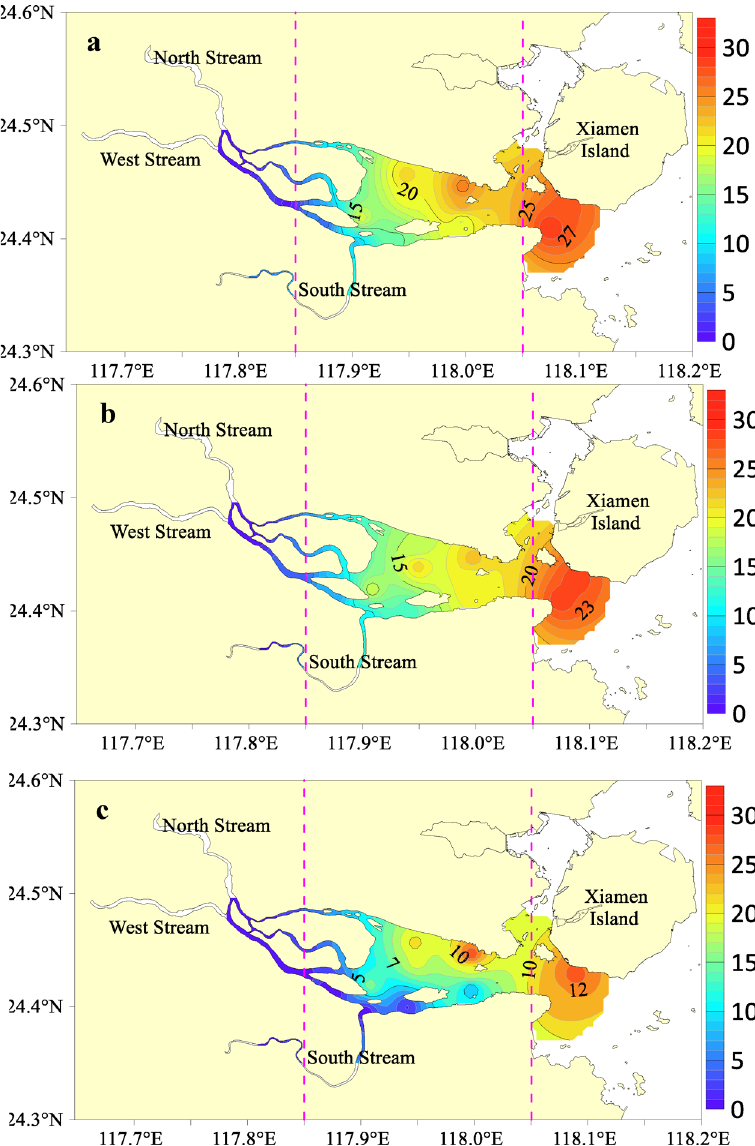
Figure 2. Horizontal distributions of the salinity in ( a ) August 2010, ( b ) November 2010, and ( c ) May 2011 in the JRE. Variations in ( d ) salinity and ( e ) temperature with longitude. These figures were created with Surfer, Version 10 (https:// www. golde nsoft ware. com/ produ cts/ surfer) ( a–c ) and Sigma-Plot Version 10.0 (Systat Software, Inc., San Jose, California, USA) ( d,e